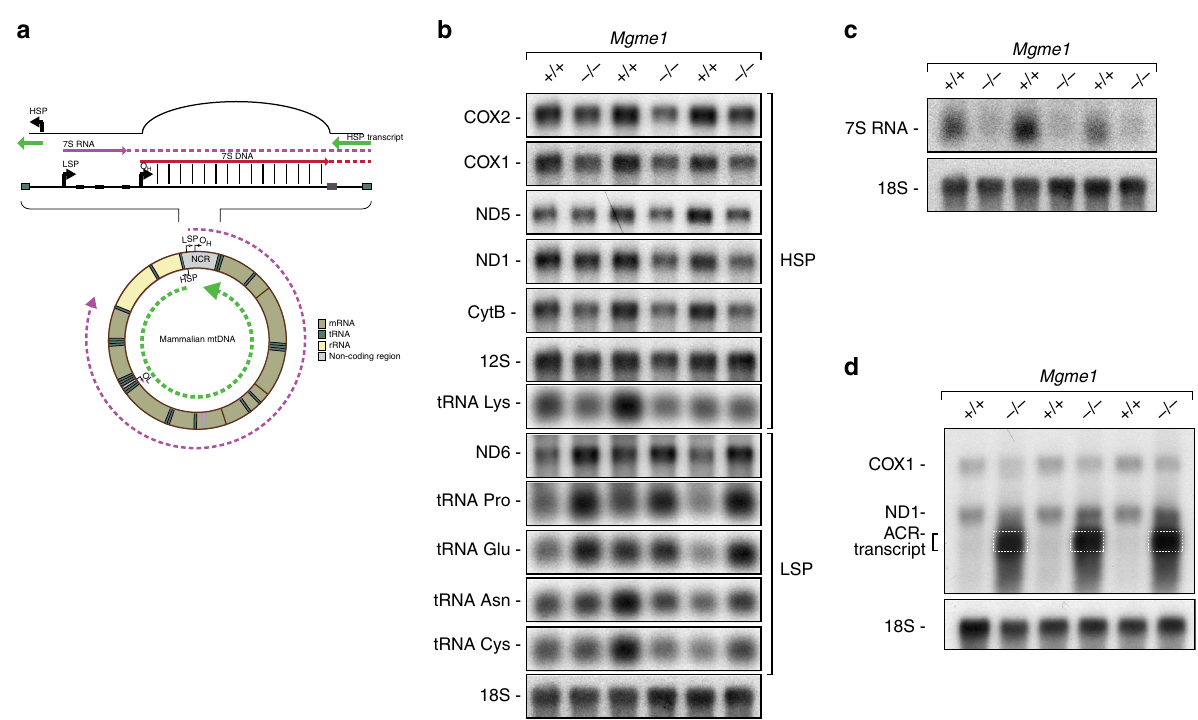
Fig. 7 Steady-state levels of mitochondrial transcripts in Mgme1 knockout mice. a Schematic representation of mtDNA with focus on NCR (non-coding region). Green line heavy-strand transcripts, pink line light-strand transcripts. Red line heavy-strand replication, HSP heavy-strand transcription promoter, LSP light-strand transcription promoter, O H origin of heavy-strand replication, O L origin of light-strand replication b Steady-state levels of mitochondrial mRNAs, rRNAs, and tRNAs; Nuclear 18S rRNA is used as a loading control. COX1 (Cytochrome oxidase subunit 1); COX2 (Cytochrome oxidase subunit 2); ND5 (NADH-ubiquinone oxidoreductase chain 5); ND1 (NADH-ubiquinone oxidoreductase chain 1); ND6 (NADH-ubiquinone oxidoreductase chain 6); CytB (Cytochrome reductase subunit b). c Northern blot analysis of 7S RNA levels in heart from control ( L/L ) and Mgme1 tissue-speci fi c knockout mice ( L/ L, cre ) and Mgme1 knockout mice ( − / − ) and corresponding control ( + / + ); loading control is nuclear 18S rRNA. Figures b and c are derived from the same northern blot membrane. d The ACR transcript mapped by northern blot analysis, using single-stranded riboprobe complementary to the mtDNA light- strand control region. ND1 and COX1 transcripts were used as size indicators and 18S nuclear rRNA was used as a loading control. ACR transcript is indicated by dotted